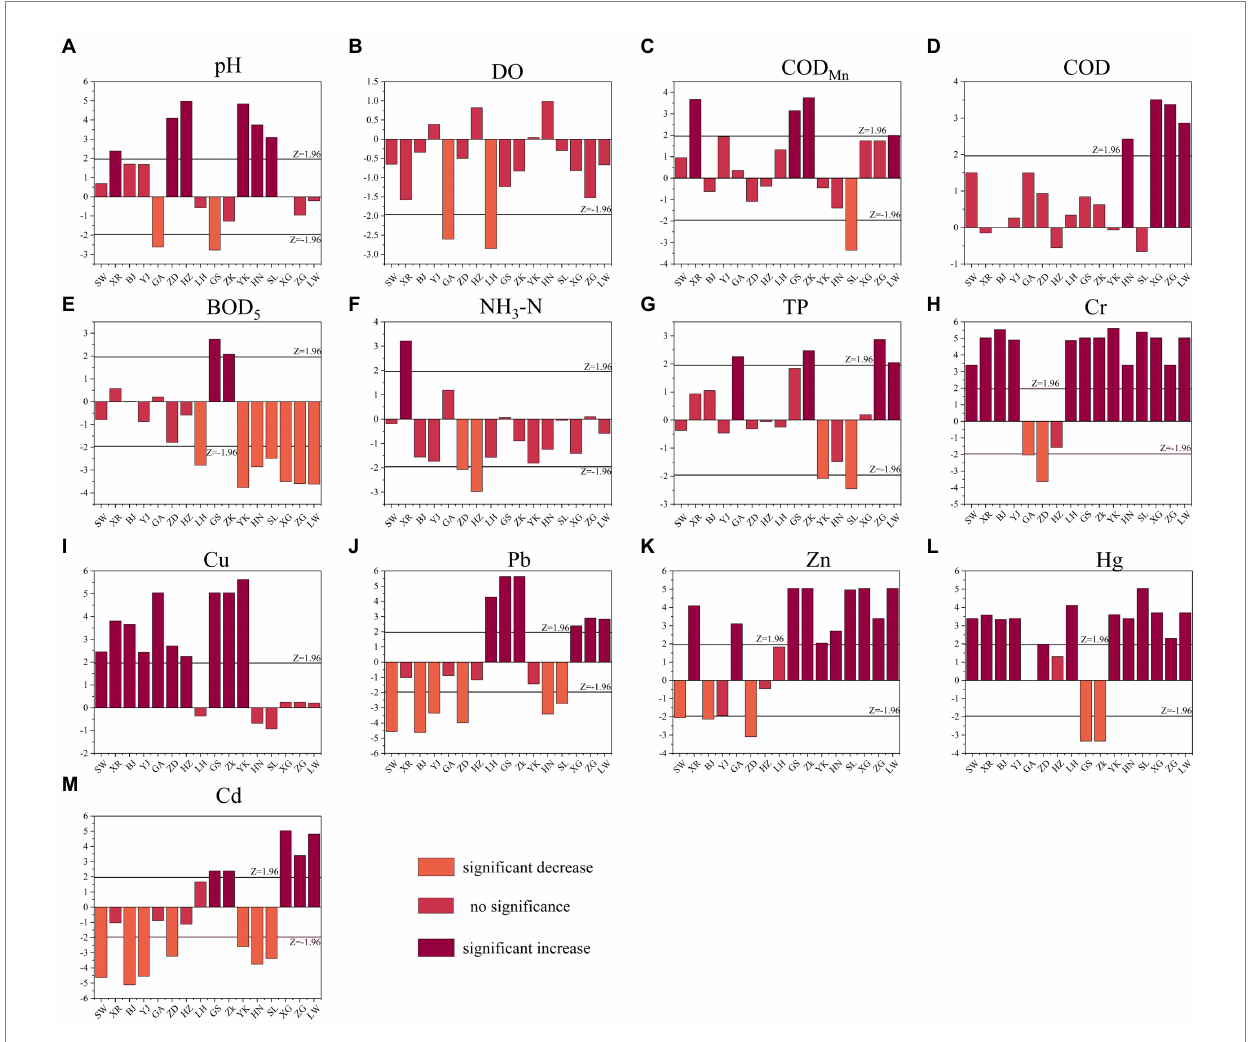
FIGURE 3 The Mann-Kendall test results of water quality indicators at different sites in the Hanjiang River: (A) pH, (B) DO, (C) COD Mn , (D) COD, (E) BOD 5 , (F) NH 3 -N, (G) TP, (H) Cr, (I) Cu, (J) Pb, (K) Zn, (L) Hg, (M)